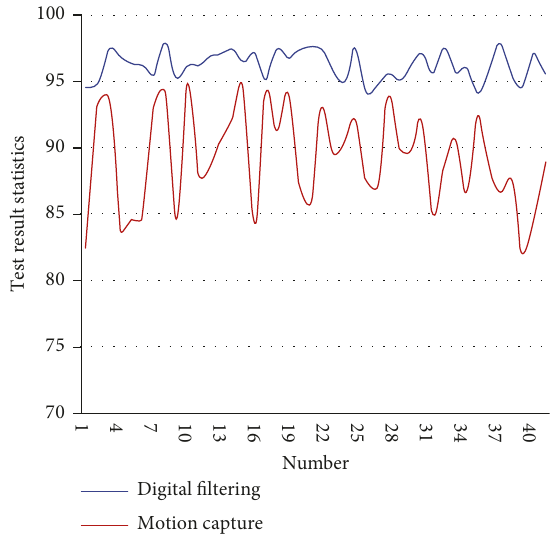
Figure 15: System performance